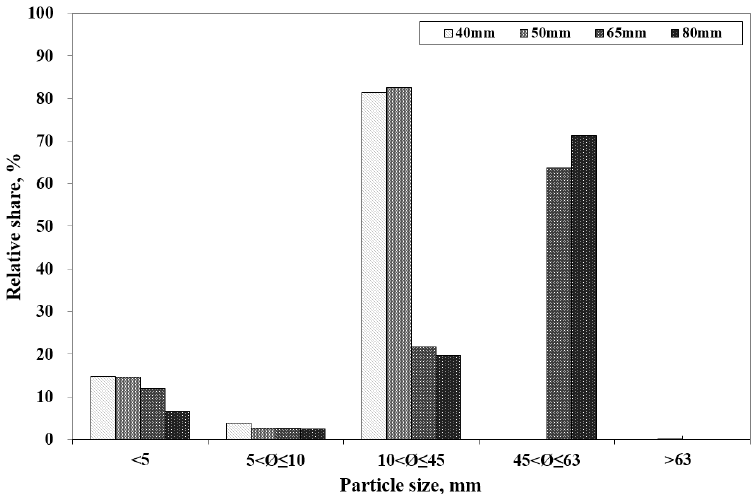
Figure 8. Particle size distribution as a percentage of screen size. (Mosture content., 31.9% (40 mm), 26.8% (50 mm), 30.6% (65 mm), 33.0% (80 mm).